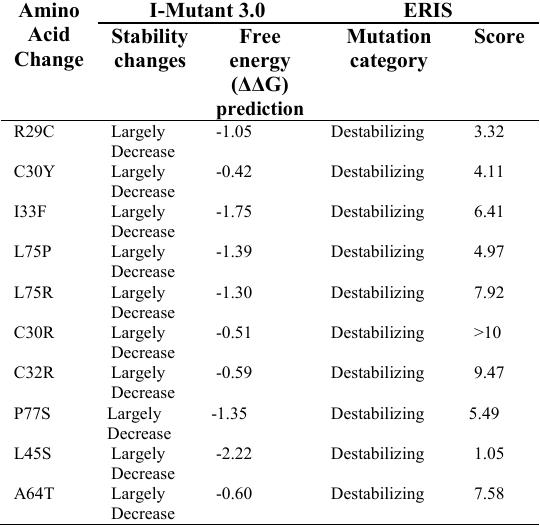
Table 4. Prediction of the protein stability upon amino acid substitutions by I-Mutant 3.0 and ERIS.